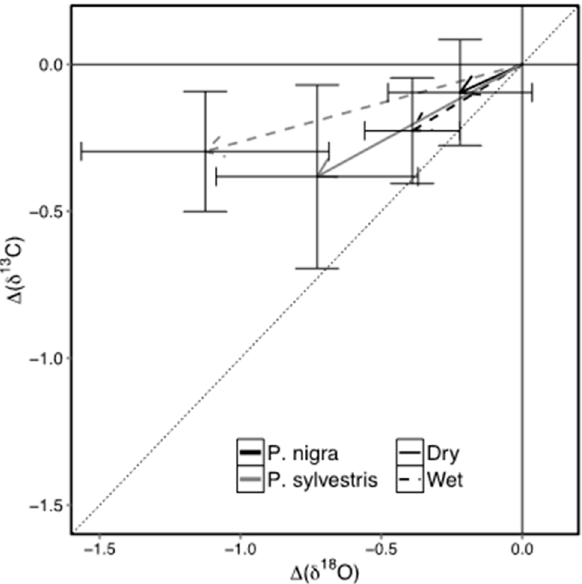
Figure 7. Change of isotopic ratios for carbon [ ∆ ( δ 13 C)] and oxygen [ ∆ ( δ 18 O)] during dry (solid line) and wet (dashed line) years with respect to the average year for P. nigra (black lines) and P. sylvestris (grey lines). Each point represents the mean of changes for five trees in three years. Error bars represent the standard error of their respective isotopic ratio change. Dotted diagonal line represents a 1:1 change. Solid vertical and horizontal lines indicate zero anomaly in the dual isotopic model.